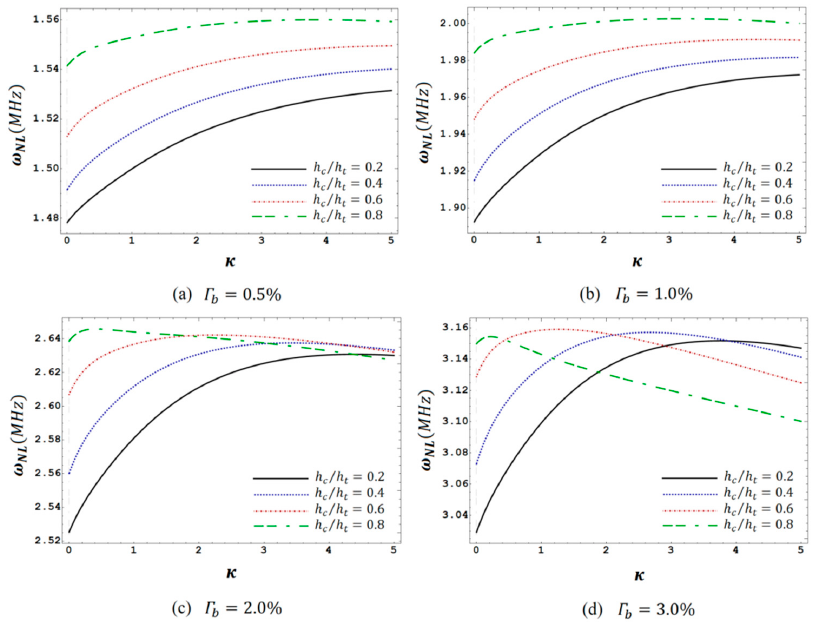
Figure 7. Variation of the first-order nonlinear frequency of a GPL-reinforced sandwich beam due to an increasing power-law parameter, for different core-to-beam thickness ratios and total amount of GPLs reinforcement in the beam ( (cid:1840) = 10,(cid:2293) ℎ (cid:3047) ⁄ = 1,(cid:1838) ℎ (cid:3047) ⁄ = 10 ).